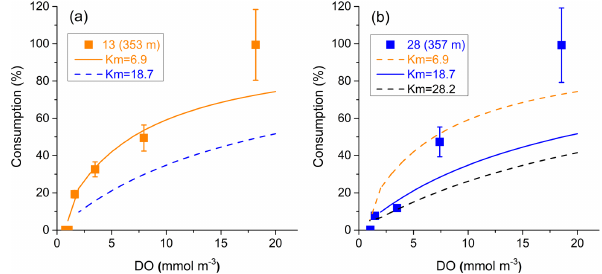
Figure 3. Relationship between biological consumption and DO concentration at (a) station 13 (353m) and (b) station 28 (357m) in the Peruvian OMZ. K m is the half saturation constant from the fitting curve derived from data of Kalvelage et al. (2015). For sta- tion 28, two K m values are derived using four (excluding the small- est value, blue curves) and five (black curve) data points, respec- tively. Since the curve with K m = 28 . 2 is too far away from most of the data points, the value 18.7 is selected as the half saturation